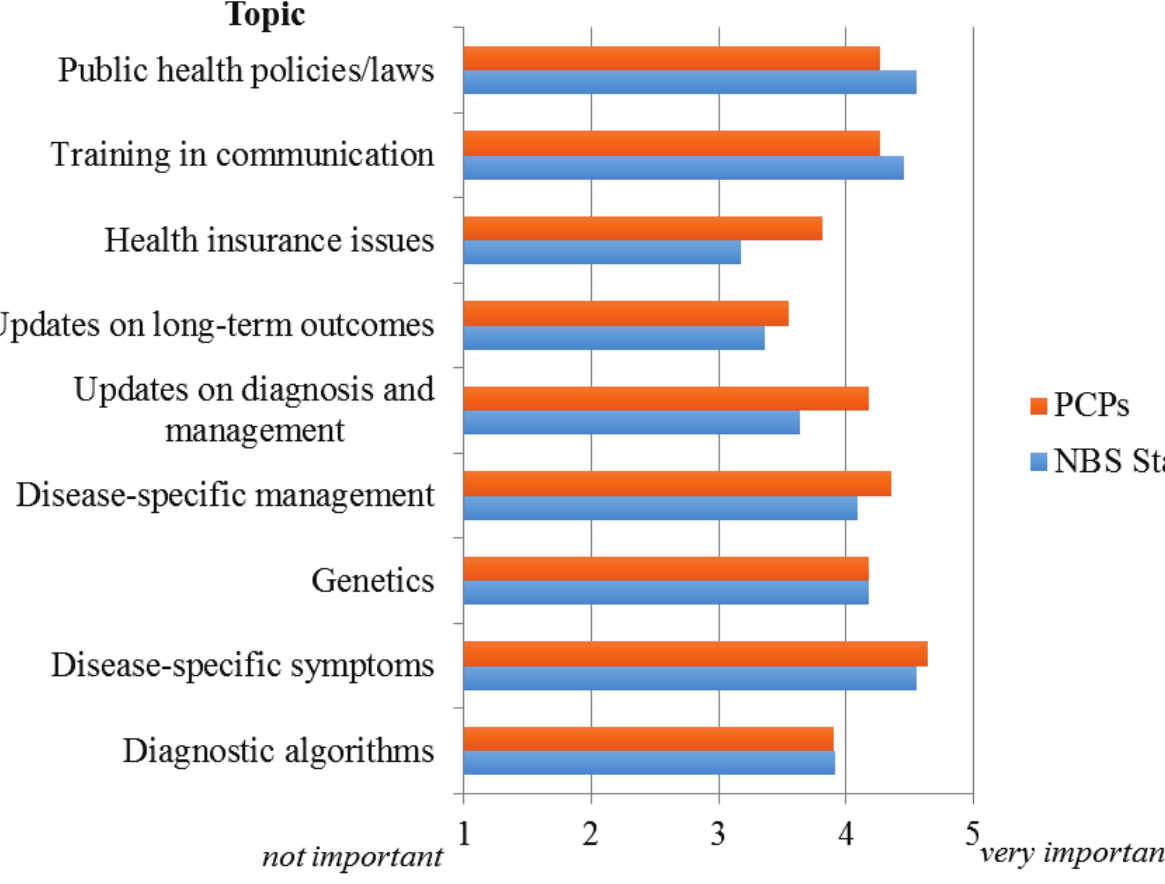
Figure 2. Perceived importance of providing educational and information resources to NBS staff and